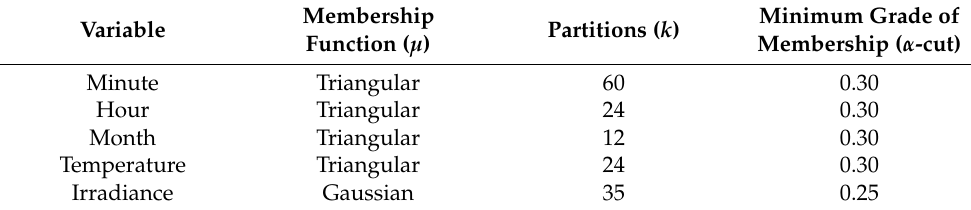
Table 5. Configuration of the variables used in the model.